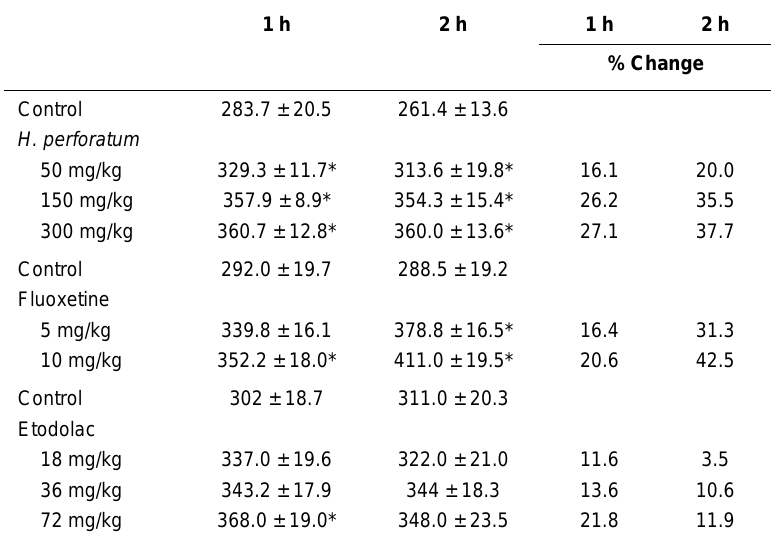
Antinociceptive Activity of H. perforatum in the Tail Electric Stimulation Test in